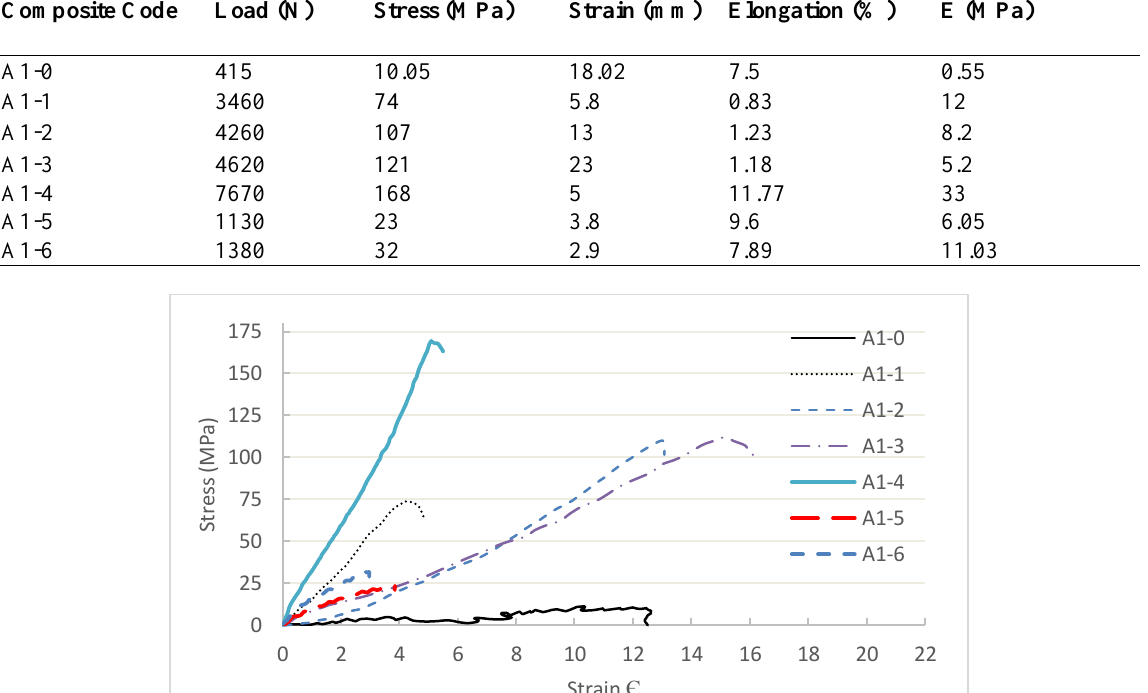
Fig. 8. Stress-Strain curves for experimental tensile tests of (A1-0, A1-1, A1-2, A1-3, A1-4, A1-5, and